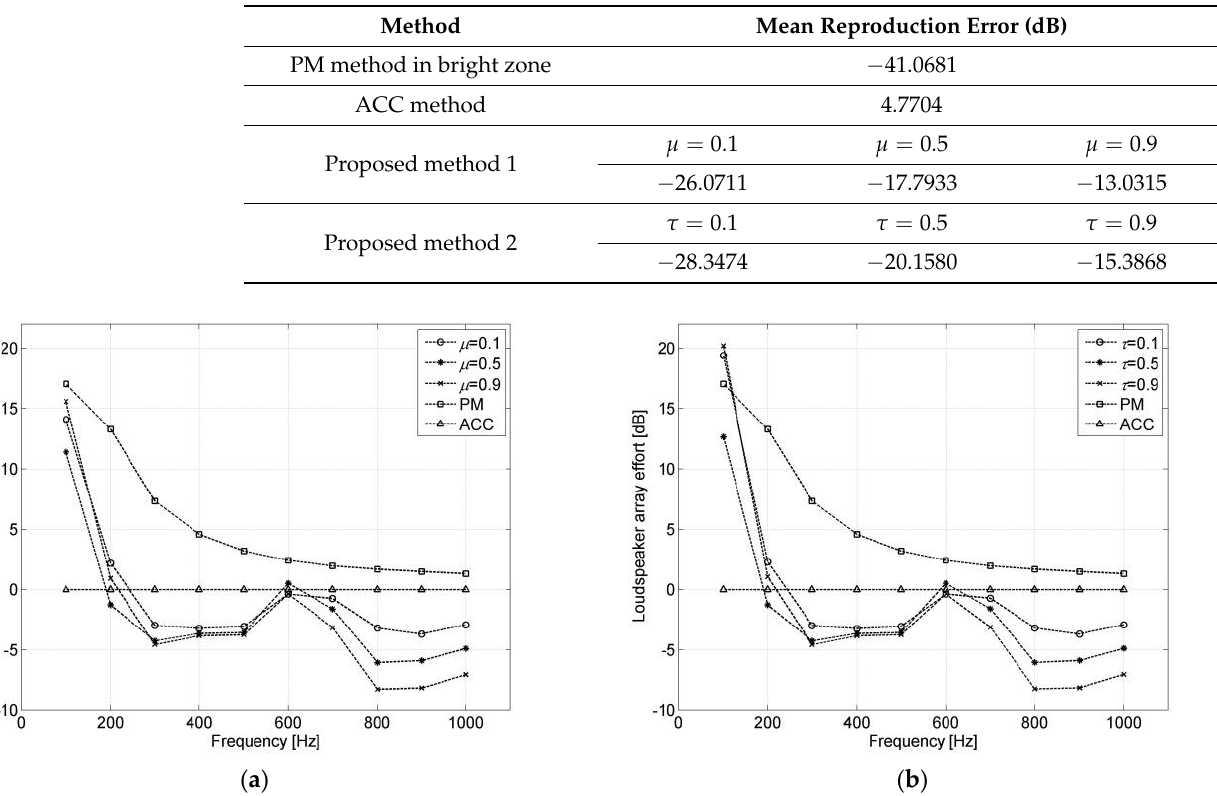
Figure 9. Array effort of different methods for three-dimensional experiment. ( a ): PM method in bright zone, ACC method, the first proposed method, with µ = 0.1, 0.5 and 0.9, respectively; ( b ): PM method in bright zone, ACC method, the second proposed method, with τ = 0.1, 0.5 and 0.9, respectively.